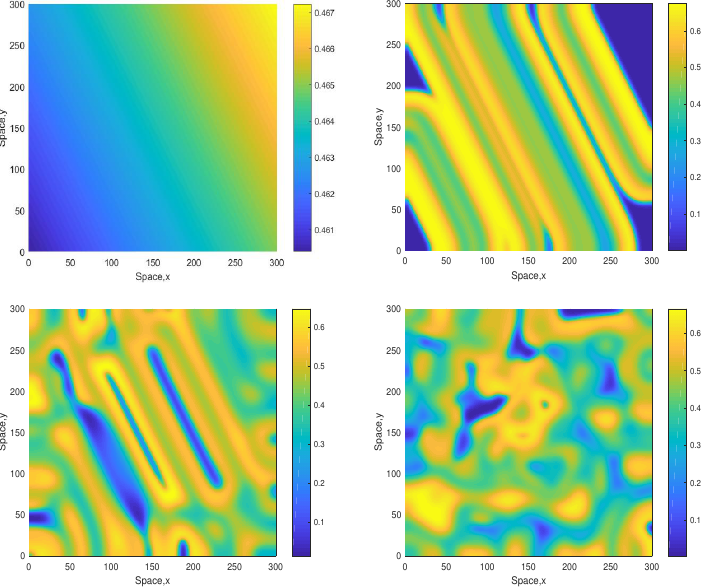
Figure 2. Snapshots of the oxygen spatial distribution obtained for A = 2.09 and shown for for t = 1, t = 200, t = 500 and t = 1100 (left to right, top to bottom), other parameters are given in the text. The initial conditions are given by Equations (10)–(12) where c 0 = 0.4638, u 0 = 0.4179 and v 0 = 0.1343.